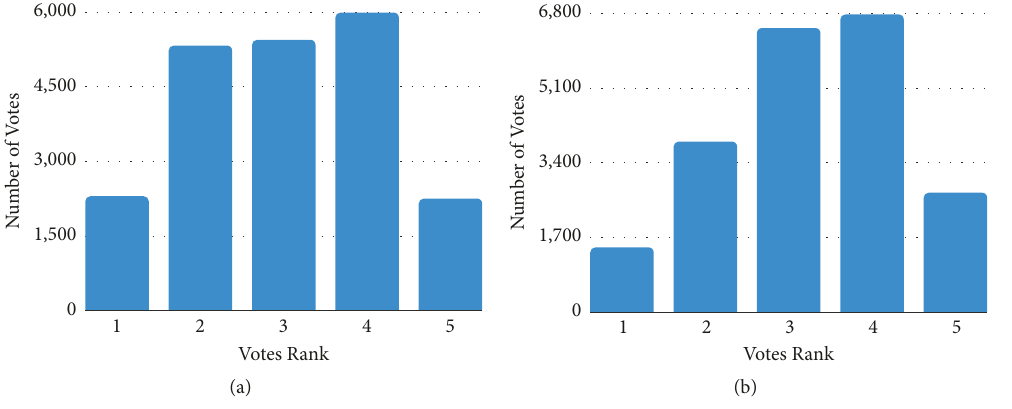
Figure 3: Distribution of the mean aesthetic (a) and quality (b) ratings obtained in the control